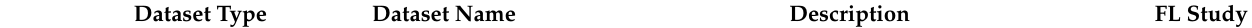
Table 3. Summary of public medical datasets in recent FL studies applied for a medical area for algorithm benchmarking. Dataset